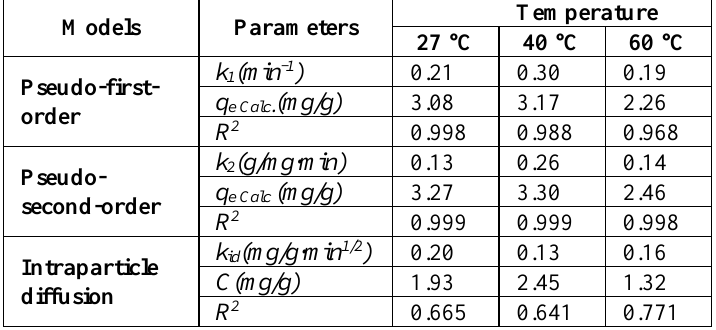
Table 4: Kinetic parameters for the adsorption of phenol on SBFA.